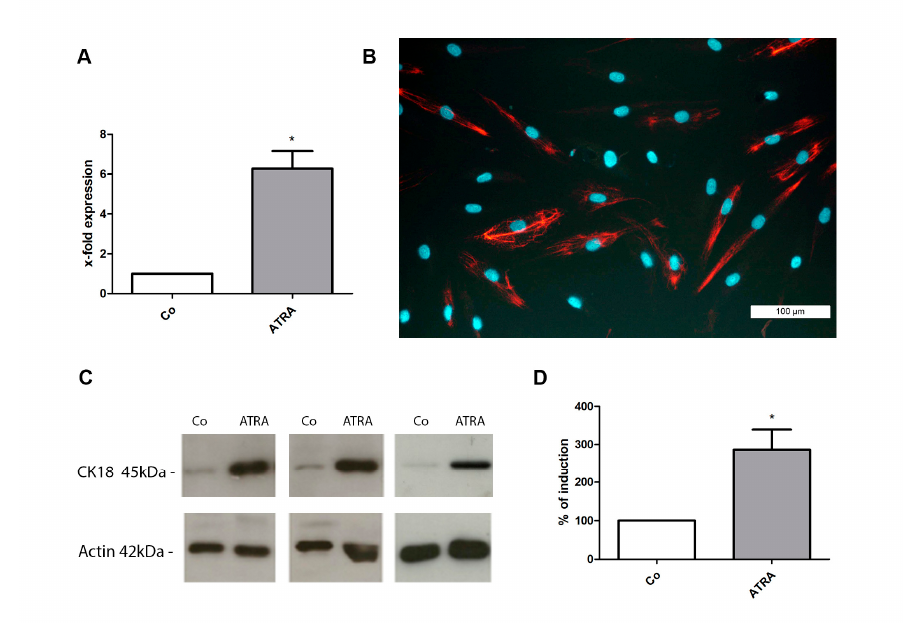
Figure 3. Induction of epithelial differentiation. ( A ) Analysis of cytokeratin 18 (CK-18) induction by qPCR. The expression levels in each experiment were normalized using β -actin as a housekeeping gene and are expressed relative to the unstimulated control using the ∆∆ CT method (n = 6; * p < 0.05); ( B ) Characteristic immunofluorescence staining of CK-18 after epithelial differentiation with ATRA (14 days). Nuclei were stained with DAPI (bar: 100 µm); ( C ) Characteristic Western blots. Expression of CK-18 (45 kDa) and β -actin (42 kDa) of the unstimulated control cells (Co) and after incubation with ATRA (5 µM) for 14 days; ( D ) Densitometric evaluation of CK-18 induction in relation to undifferentiated controls (= 100%) ( n = 5; * p <